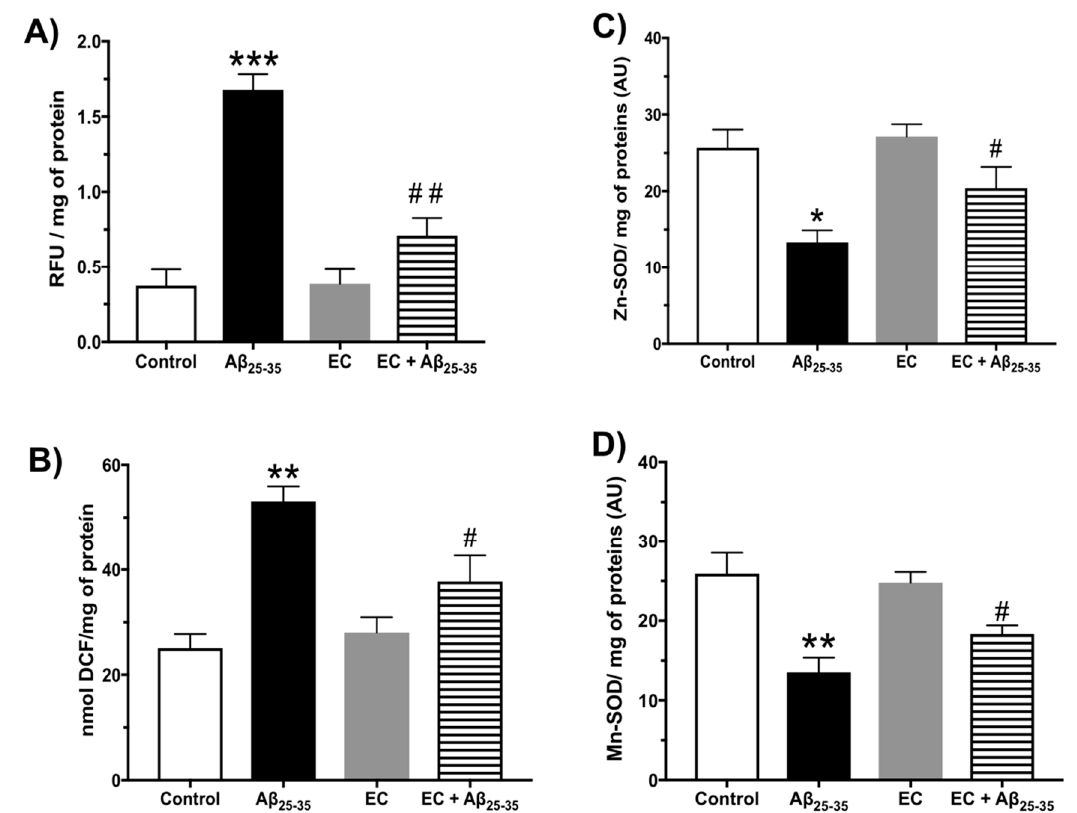
Figure 2. Effect of epicatechin on oxidative stress in the Hp of rats injected with A β 25–35 . ( A ) Reactive Oxygen Species (ROS) assay; ( B ) lipid peroxidation assay; ( C ) Zn-Superoxide activity assay; ( D ) Mn-Superoxide activity assay. The mean ± SE is plotted. Data were analyzed with one-way ANOVA and post-test Bonferroni test. (* p < 0.05; ** p < 0.01; and *** p < 0.001) comparing all groups with respect to the vehicle group. (# p < 0.05 and ## p < 0.01) compared the A β 25–35 group versus EC + A β 25–35 group.